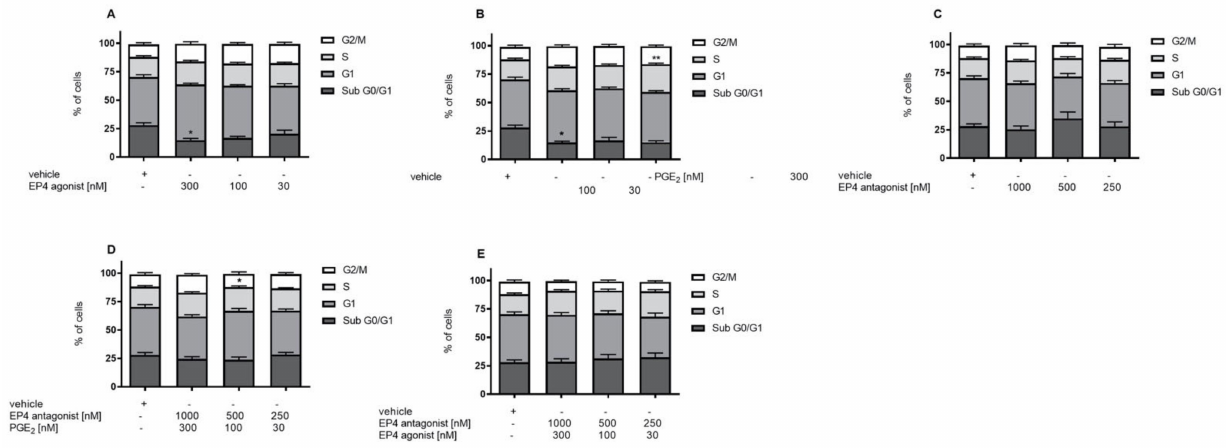
Figure 5. EP4 agonist treatment significantly decreased cells in the sub-G1 phase and increased cells in the G1 phase of DCTs. To evaluate cell viability, a cell-cycle analysis was performed. DCT cells were treated with vehicle ( n = 7), EP4 receptor agonist ( n = 6–7) ( A ) PGE2 ( n = 5–6) ( B ), EP4 receptor antagonist ( n = 5–6) ( C ), and the EP4 receptor antagonist together with PGE2 ( n = 6–7) ( D ) or together with the EP4 receptor agonist ( n = 4) ( E ) under starving conditions for 72 h. Data are shown as mean ± SEM. Statistical significances are provided compared to vehicle (* p ≤ 0.05, ** p ≤